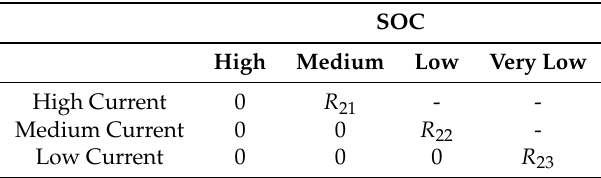
Table 3. Lookup table for R 2 . R 21 , R 22 and R 23 are estimated parameters. SOC High Medium Low Very Low High Current 0 R 21 - - Medium Current 0 0 R 22 - Low Current 0 0 0 R